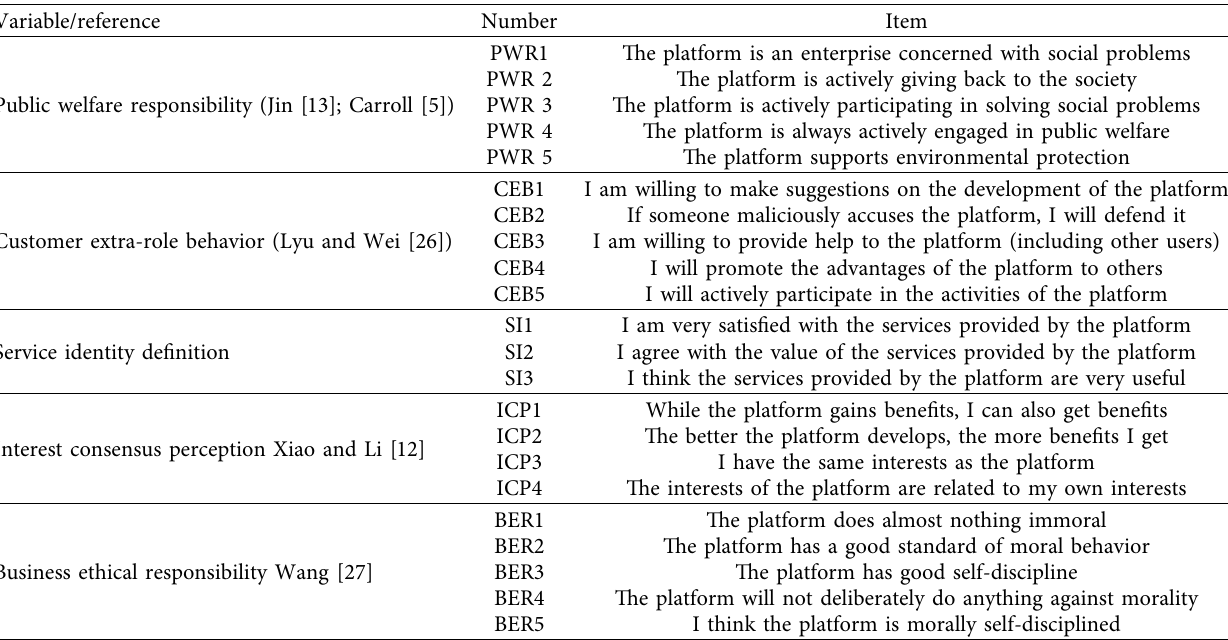
Table 1: Research